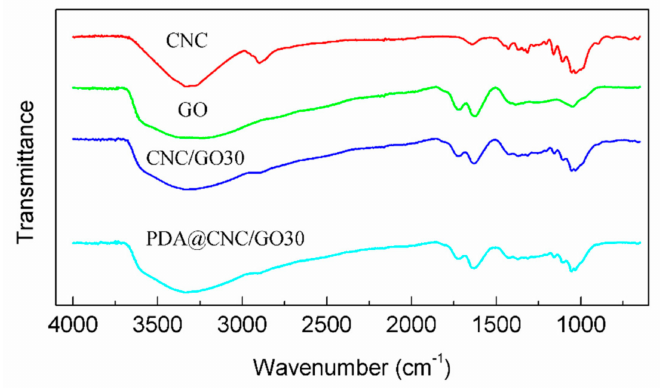
Figure 3. TEM images of: ( a ) GO; ( b ) CNC / GO30; and ( c ) PDA@CNC / GO30.